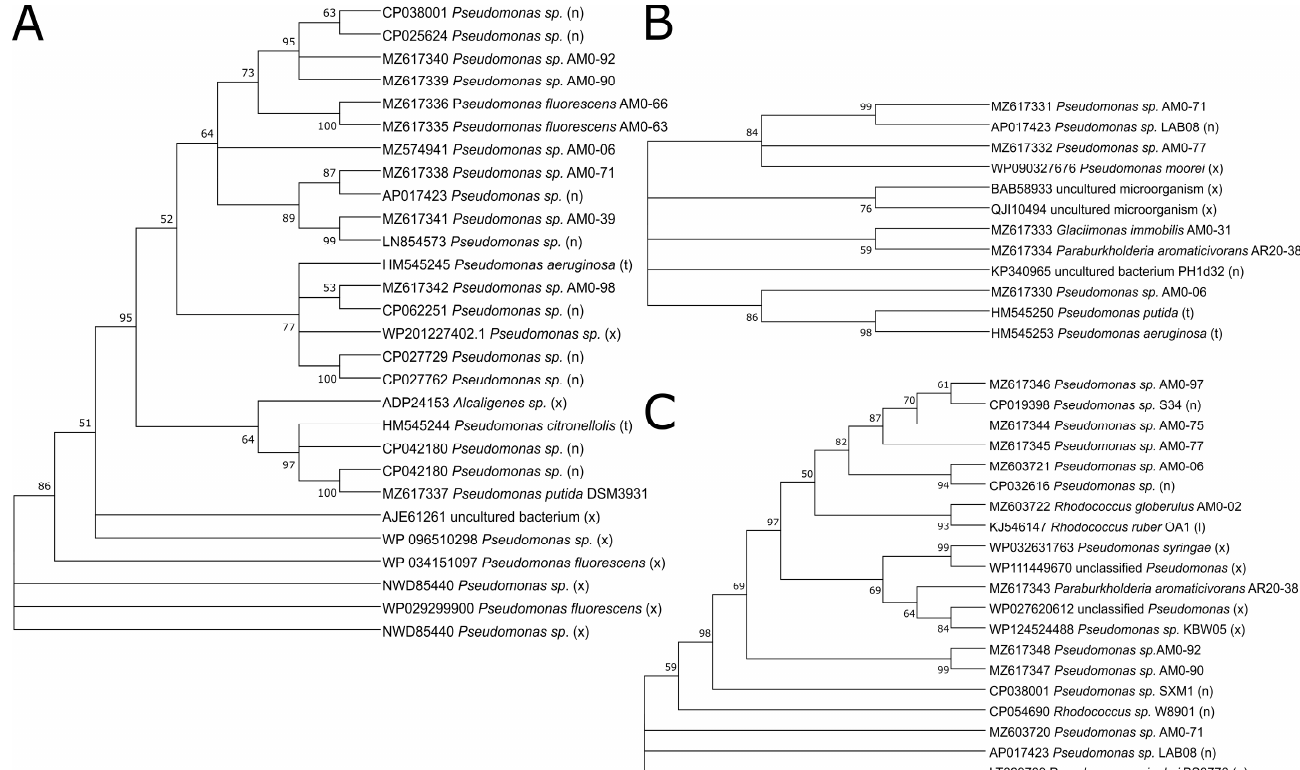
Figure 3. Phylogenetic tree of the studied ( A ) catechol-1,2-dioxygenase ( B ) multicomponent phenol hydroxylase and ( C ) protocatechuate-3,4-dioxygenase gene sequences. Strain numbers and accession numbers from GenBank are indicated. (n) and (x) indicate closest sequences based on NCBI blastn and blastx. (t) and (l) indicate published sequences by [33] and [32]. Bootstrap probabilities are shown at the branch nodes.